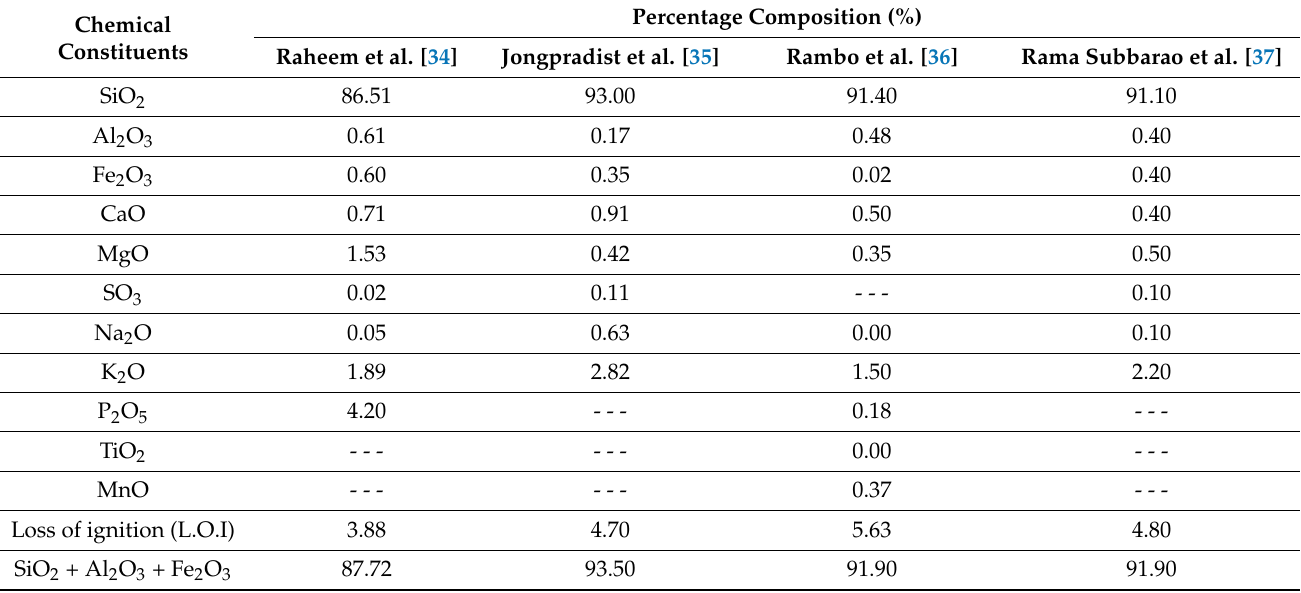
Table 1. The chemical composition of RHA from the literature indicates that silica is the major constituent of rice husk